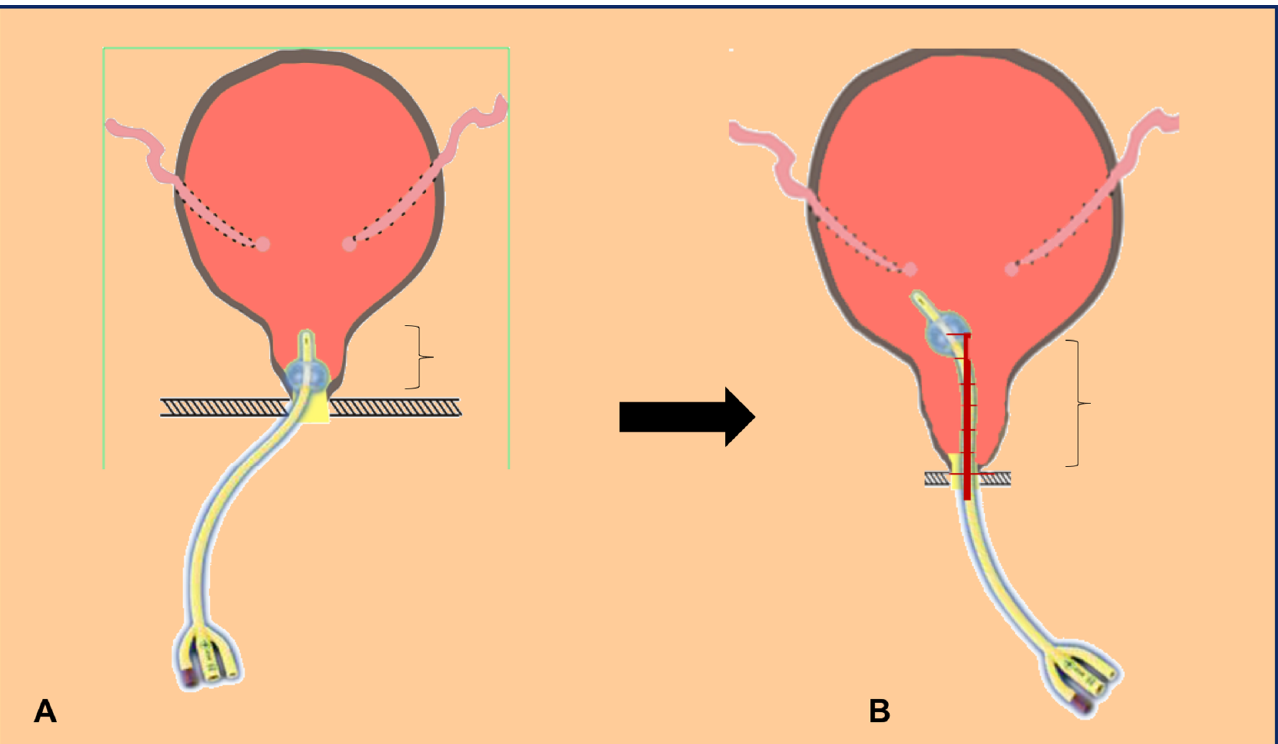
Figure 2. Schematic diagram depicting urethral lengthening at the end of the STAFER procedure. ( A ) (preoperative) and ( B ) (postoperative) images depict the length of the urethra (curly bracket). It is believed that a few millimeters of extra length can be purchased by interrupted suturing with constant traction provided by the urethral catheter.